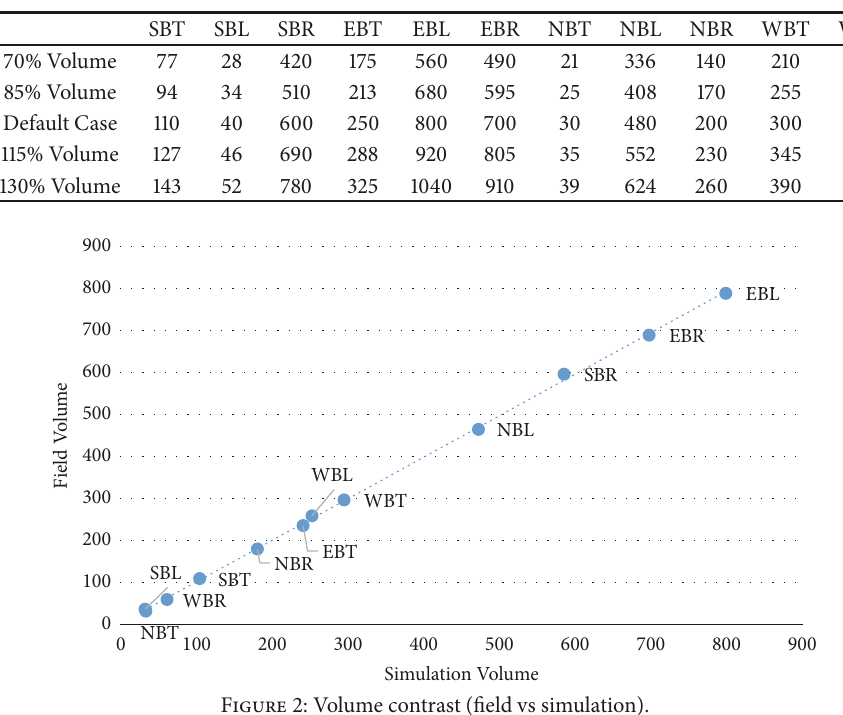
Table 1: Base scenario group.